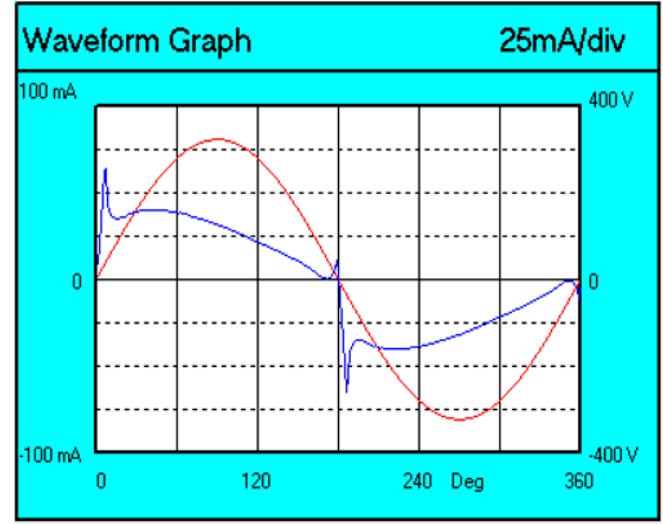
Figure 7. Voltage and current waveforms for the Osram Parathom lamp.